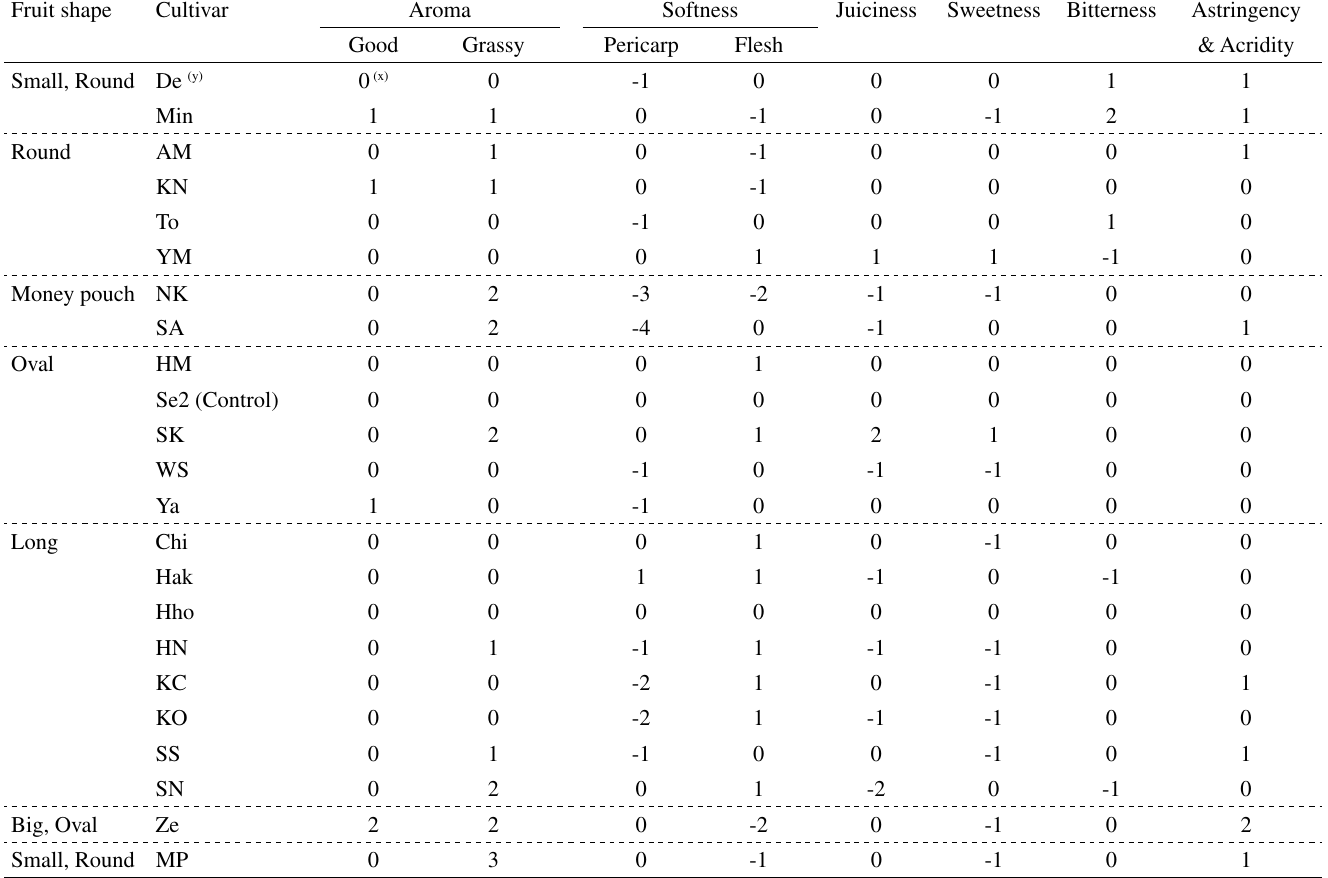
Table 2 - Evaluation of the taste of eggplant cultivars by sensory test (z)